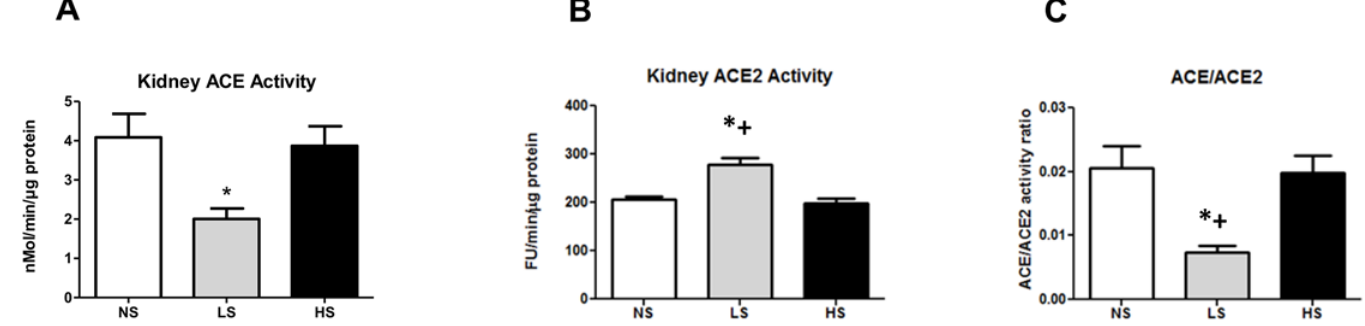
Fig 7. Renal enzymatic activity of ACE, ACE2 and the ACE/ACE2 ratio. (A) ACE enzymatic activity. (B) ACE2 enzymatic activity. (C) ACE/ACE2 ratio. Data are means ± SEM. NS: normal salt diet. LS: low salt diet. HS: high salt diet. * P < 0.05 vs. NS; + P < 0.05 vs. HS. (NS n = 12, LS n = 10, HS n = 9).